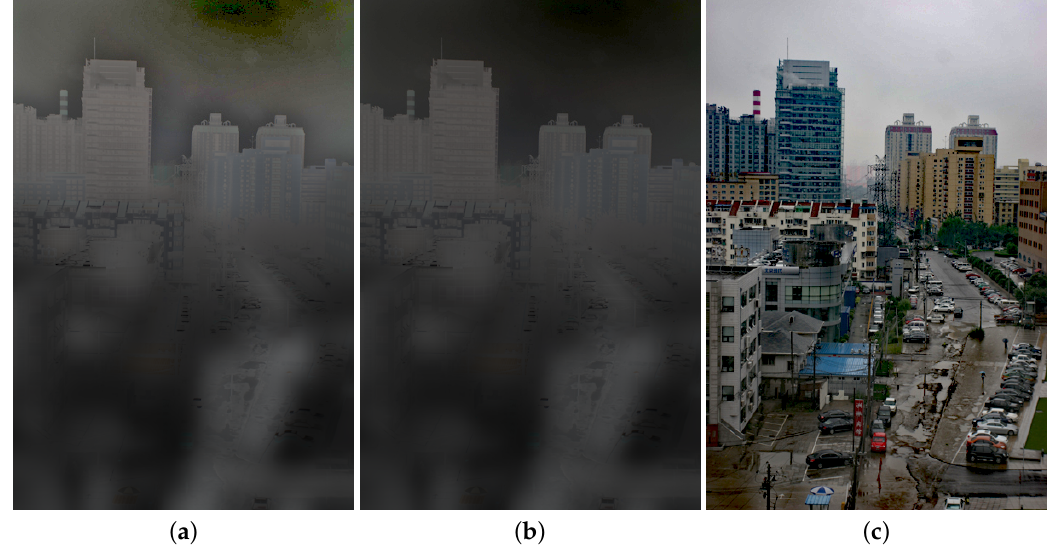
Figure 2. Effect of the residual-based approach. ( a ) The residual map; ( b ) the weighted residual map; ( c ) our final